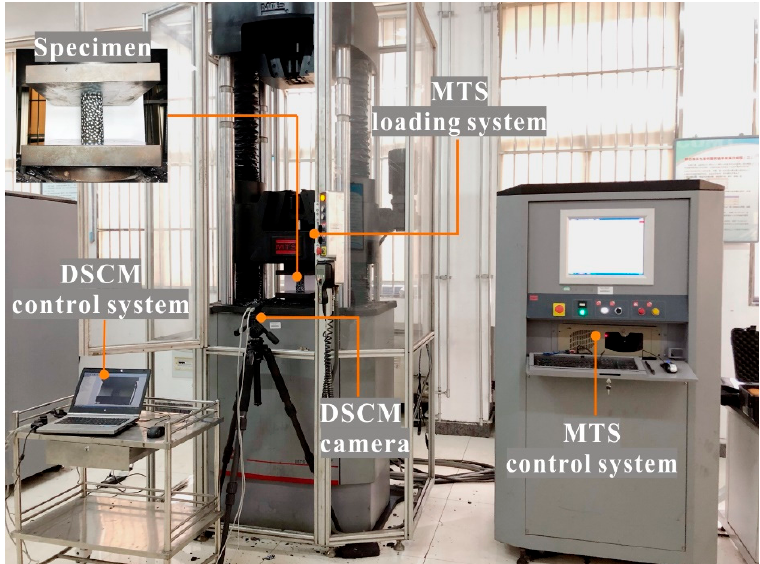
Figure 4. Mechanical testing simulation (MTS) test system and digital speckle correlation method (DSC)M measurement system.